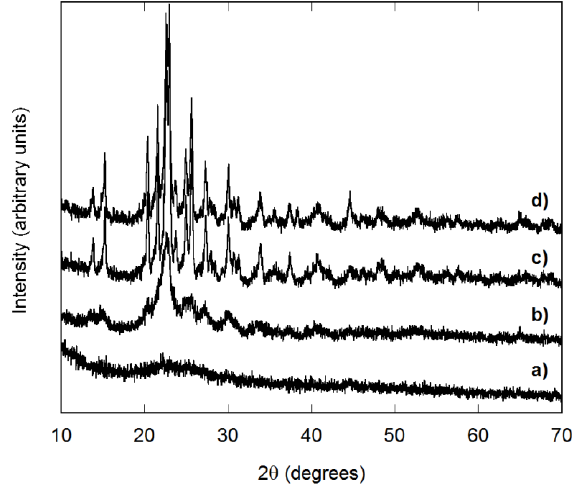
Figure 2. Laboratory PXRD data for AlScMo 3 O 12 samples: ( a ) as recovered; ( b ) heated to 500 °C; ( c ) heated stepwise to 500, 600 and 700 °C; and ( d ) heated directly to 700